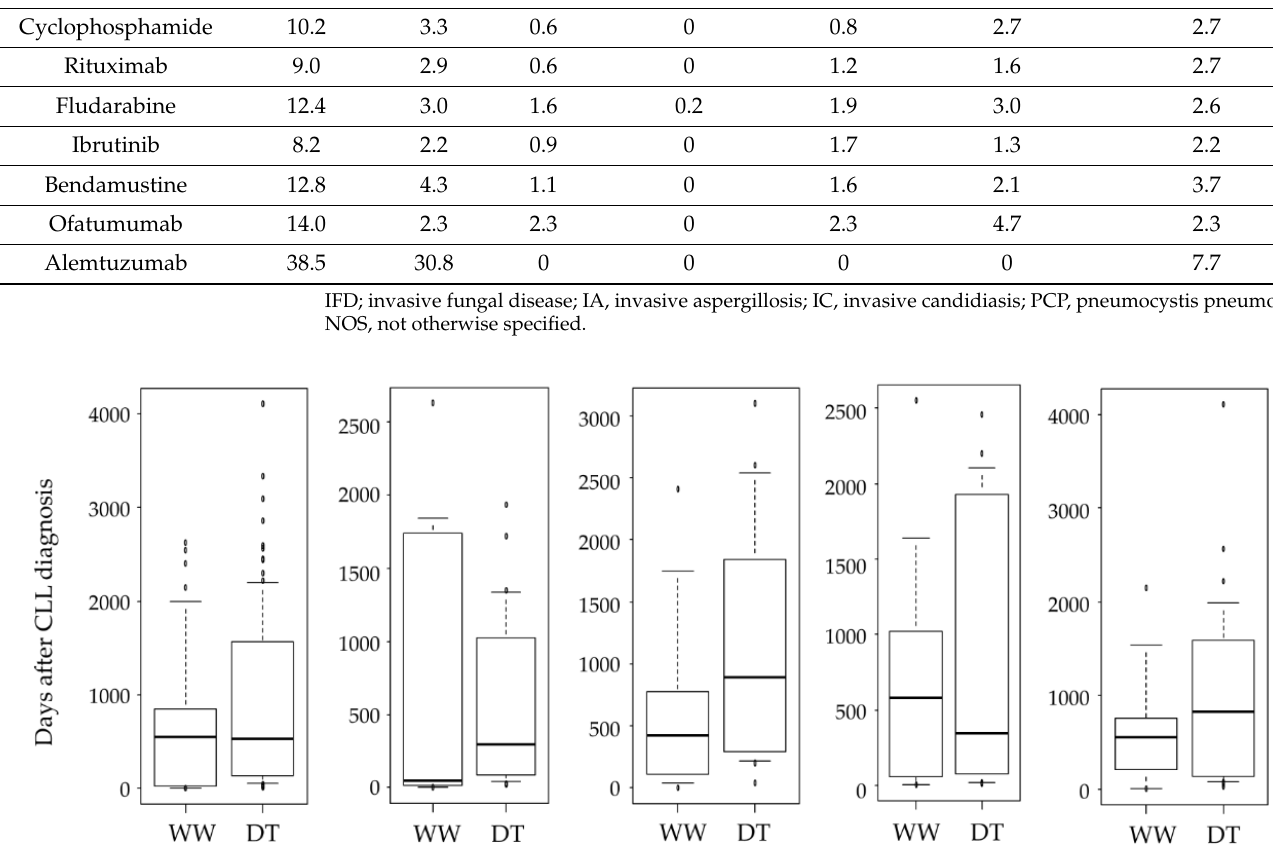
leukemia. CLL, chronic lymphocytic leukemia; WW, watch-and-wait group; DT, drug therapy group;